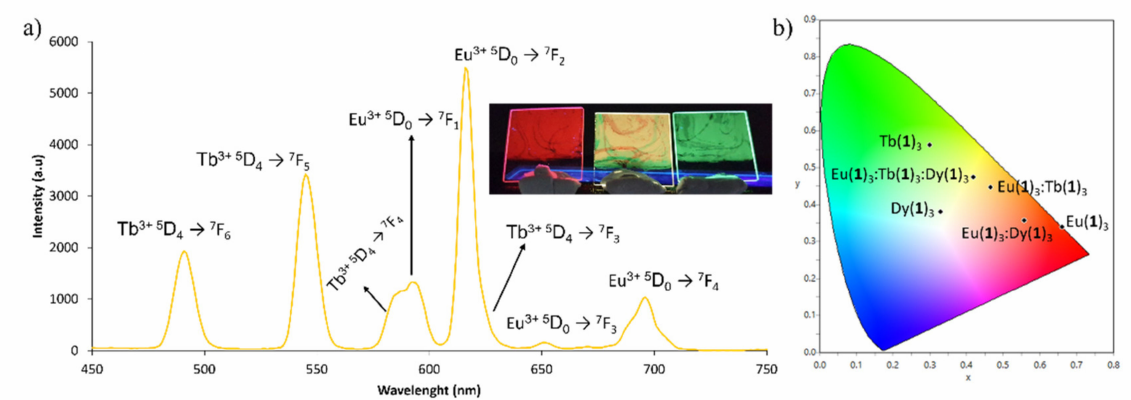
Figure 3. ( a ) Eu( 1 ) 3 :Tb( 1 ) 3 LB film fluorescence spectrum showing both Ln 3+ distinct emission